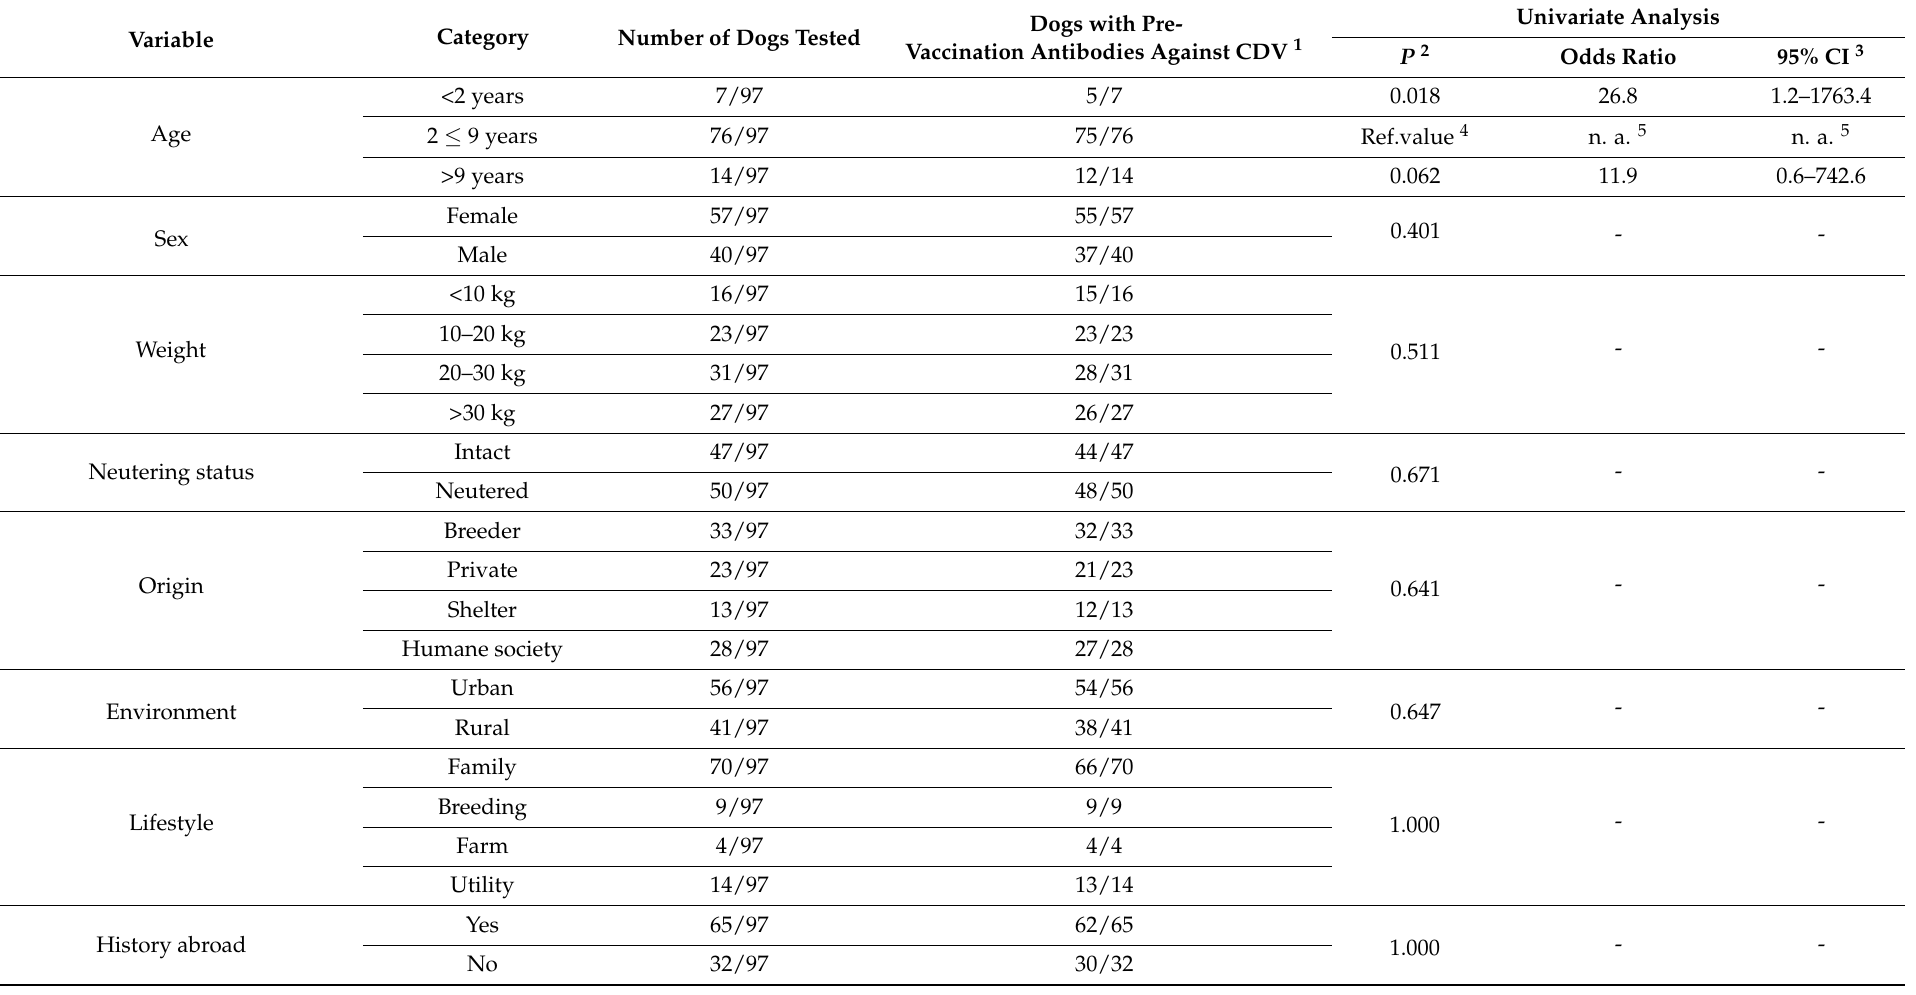
Table 1. Characteristics of dogs and their association with presence of antibodies against canine distemper virus isolate AG219 in Fisher’s exact